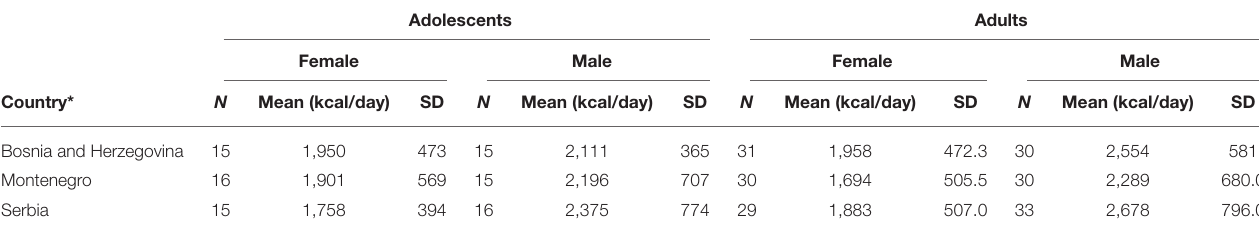
TABLE 1 | Evaluation of quality of harmonization of the DAP system functionalities.